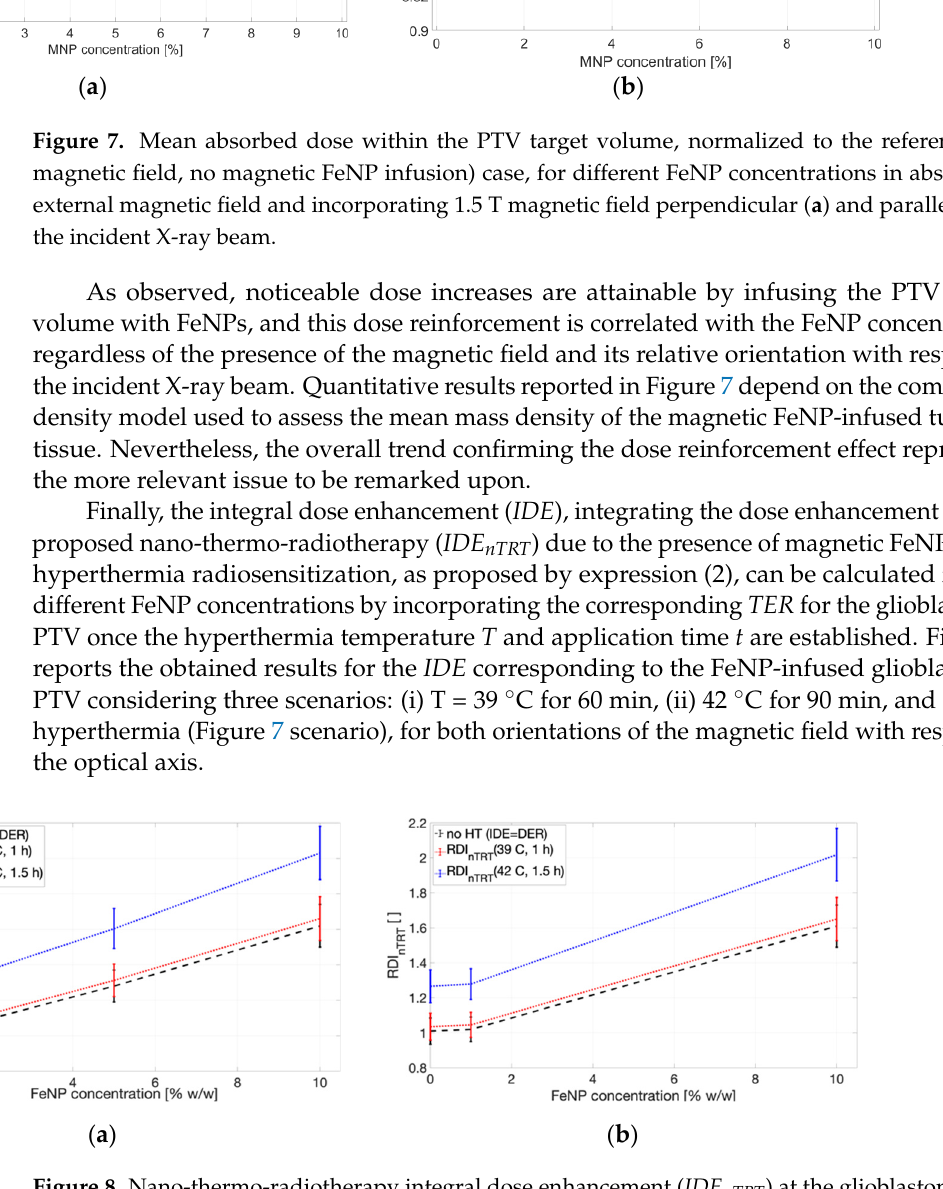
( b ) Figure 9. Illustration of charged particle tracking with Lorentz force due to magnetic field perpen ‐ dicular ( a ) and parallel ( b ) to the radiation beam. In addition, the charged particle fluence is significantly affected by the presence of the external strong magnetic field, as shown in Figures 2 and 3. Although both electrons and positrons are created as secondary charged particles when irradiating with a 6 MV beam, it is worth noting that electron fluence is significantly higher than that of positrons. In fact, electron fluence represents an acceptable approximation of the (total) charged